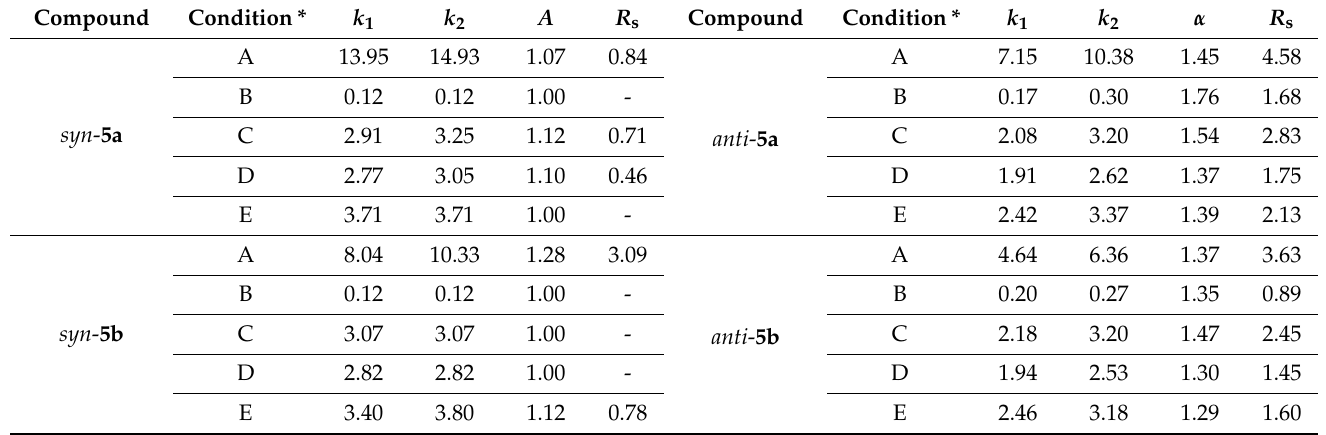
Table 2. Chromatographic parameters for the enantioselective separations of racemic syn -and anti - 3,5-disubstituted hydantoins on